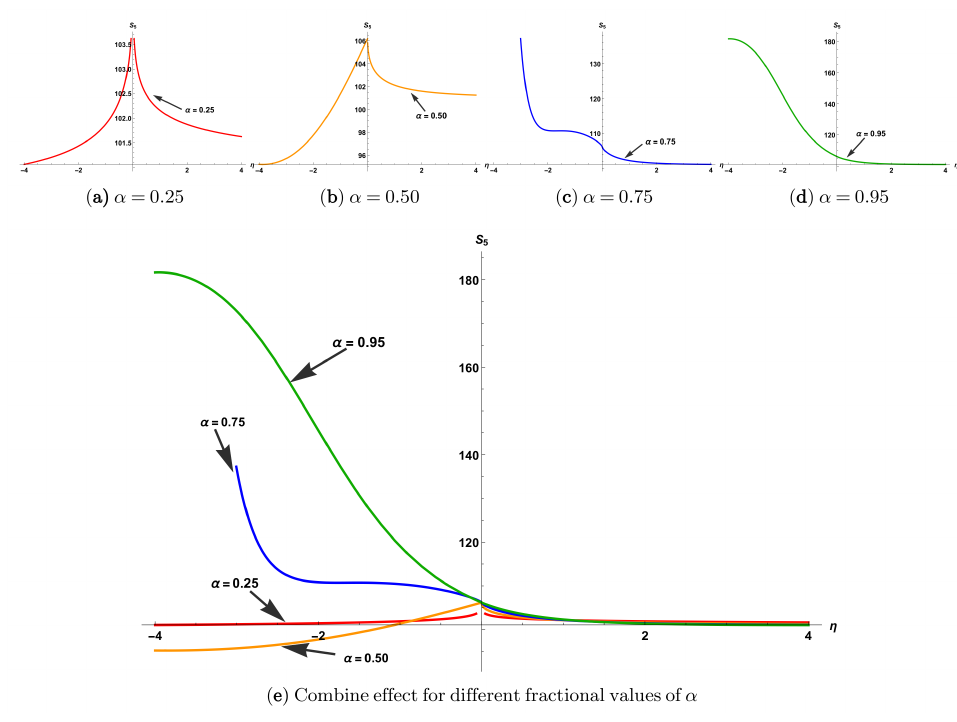
Figure 8. A 2D graphical representation for S 5 .